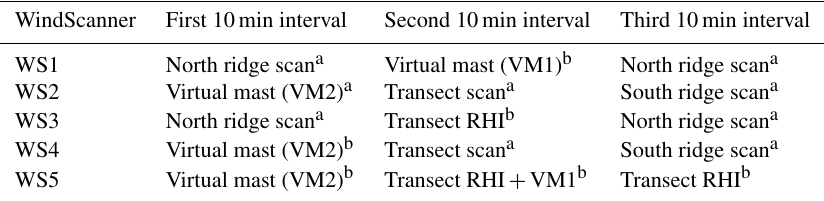
Table 1. Half-hourly repeating schedule of scanning strategies. WindScanner First 10min interval Second 10min interval Third 10min interval WS1 North ridge scan a Virtual mast (VM1) b North ridge scan a WS2 Virtual mast (VM2) a Transect scan a South ridge scan a WS3 North ridge scan a Transect RHI b North ridge scan a WS4 Virtual mast (VM2) b Transect scan a South ridge scan a WS5 Virtual mast (VM2) b Transect RHI + VM1 b Transect RHI